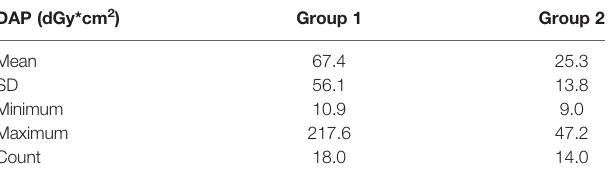
TABLE 3 | The DAP of both groups of patients (dGy*cm 2 ).